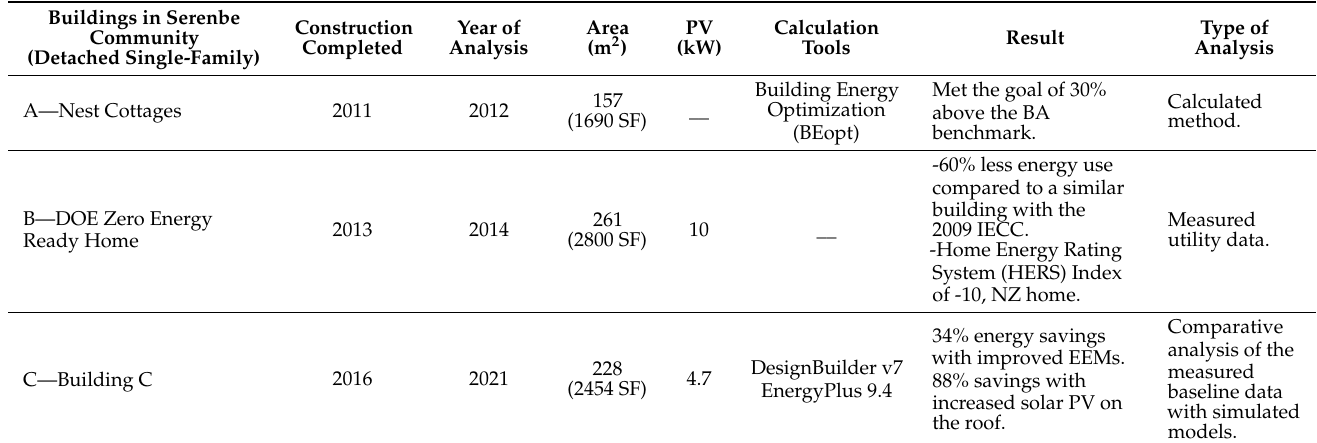
Table 9. Energy analysis of the three types of energy-efficient, single-family buildings in Serenbe.